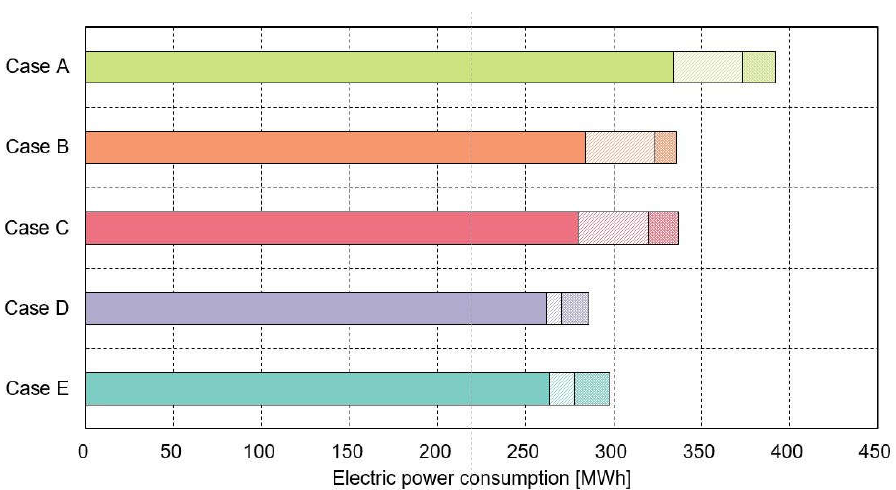
Figure 19. Annual system energy consumption for Case A–E. In Case D, the low LGR algorithm operation was applied with the same condenser water set temperature as in Case C. The results revealed that the system energy was re- duced by 50.5 MWh, around a 15% savings, and for each component, the condenser water pump had the largest reduction at 78.3%, followed by the cooling tower fan at 8.4%, and